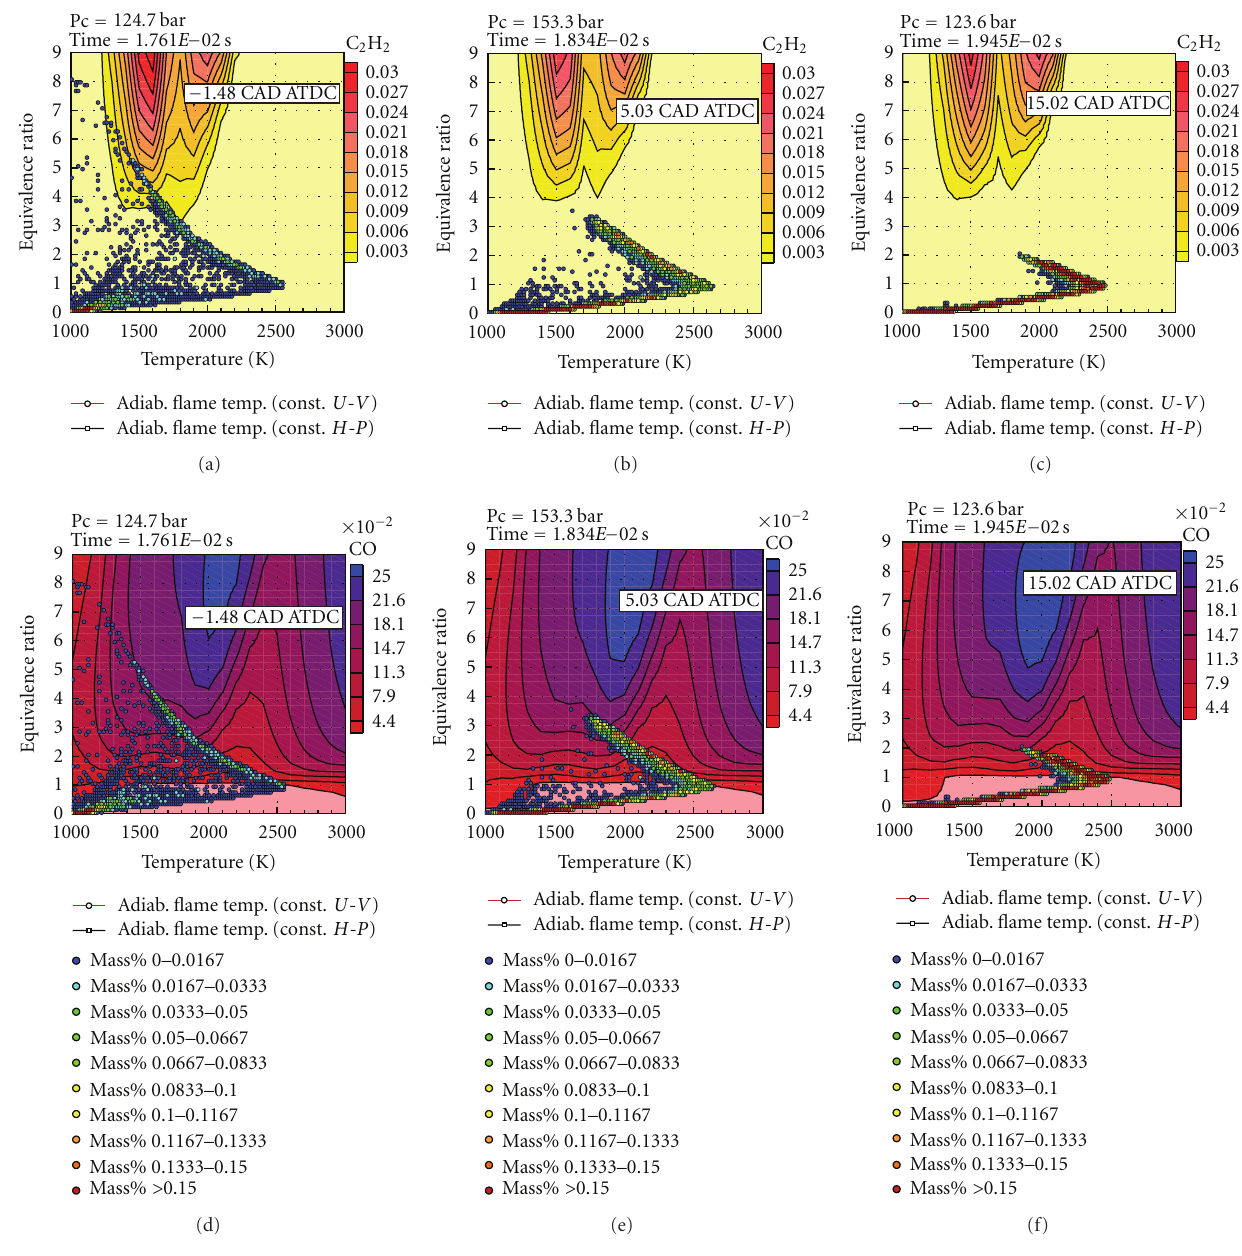
Figure 15: Parametric φ - T emission maps for instant acetylene, C 2 H 2 concentrations (upper three plots) and carbon monoxide, CO concentrations (a, b, and c) in the Volvo D12C Diesel engine fuelled by RME at di ff erent CADs ( − 1.5, 5.0 and 15.0, resp.); the engine was operated under 50% load with 30%